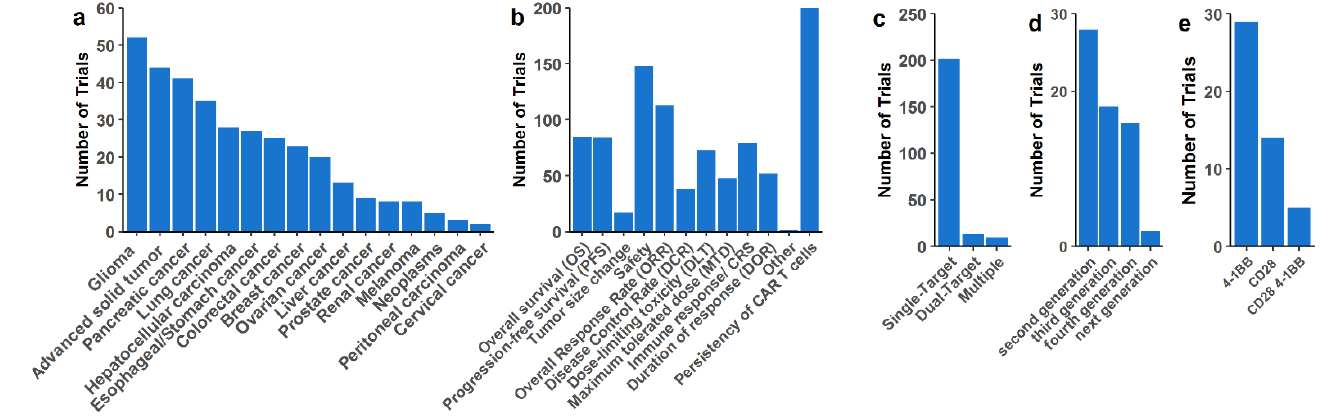
Figure 3. CAR-T cell strategies for solid tumors under clinical trial evaluation. ( a ) Solid tumors treated by CAR-T cells under clinical trials. The term “Advanced solid tumors” was applied when the trial description used the same terminology, and the tumor origin could not be accessed. If the trials described several tumors, all of them were marked as separated entities. ( b ) Primary and secondary endpoints of clinical trials. All endpoints for a given trial are presented in this graph. ( c ) Number of simultaneous targets by one CAR or combination of different CAR-T cells delivered at once or in sequence for the patients. ‘Multiple’ includes three or more targets at once. Several targets for multiple patients were considered as single-target therapy. ( d ) CAR generation used in clinical trials. ( e ) Number of clinical trials with CD28 and/or 4-1BB costimulatory signal on CAR constructs.